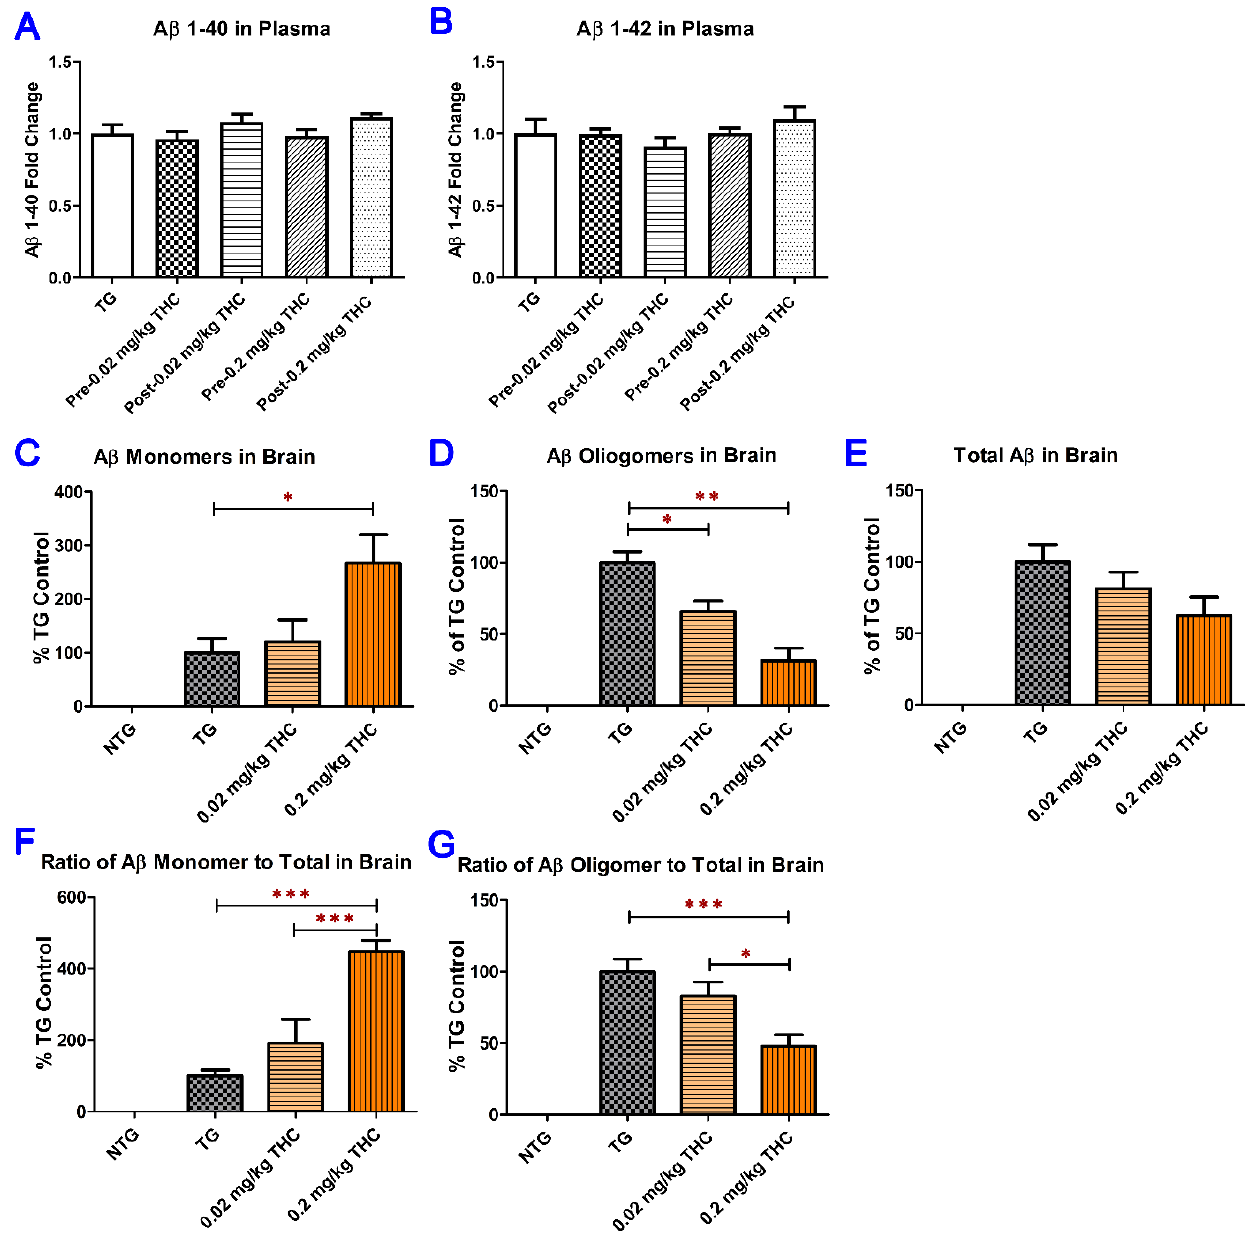
Figure 6. Determination of both soluble and insoluble A β 1–40 ( A ) and A β 1–42 ( B ) levels in the plasma using ELISA. Plasma samples were collected from the APP/PS1 mice before the start and after the 3-month THC treatment. No significant difference in soluble and insoluble A β 1–40 and A β 1–42 levels in plasma was found among all treatment groups and between the baseline and post- treatment levels ( N = 7 for the control NTG group, N = 6 for the control TG and 0.2 mg/kg THC groups, and N = 8 for the 0.02 mg/kg THC group). Determination of A β monomers ( C ), A β oligomers ( D ), and total A β ( E ) in mouse brain tissue using the semi-quantitative western blotting and the total A β normalized A β monomer ( F ) and oligomer levels ( G ). The total A β normalized A β monomer (or oligomer) level was calculated as the ratio of A β monomer (or oligomer) level to total A β level. Treatment with 0.2 mg/kg THC significantly increased the A β monomer level and decreased A β oligomer level compared with the control treatment in TG mice. Data are expressed as mean ± SD ( N = 6 for each study group). SD is denoted by the error bars. * p < 0.05, ** p < 0.01, and *** p < 0.001 compared between the control NTG mice, control APP/PS1 mice, and APP/PS1 mice treated with 0.02 and 0.2 mg/kg THC using one-way ANOVA followed by the Tukey–Kramer post hoc multiple comparison test.